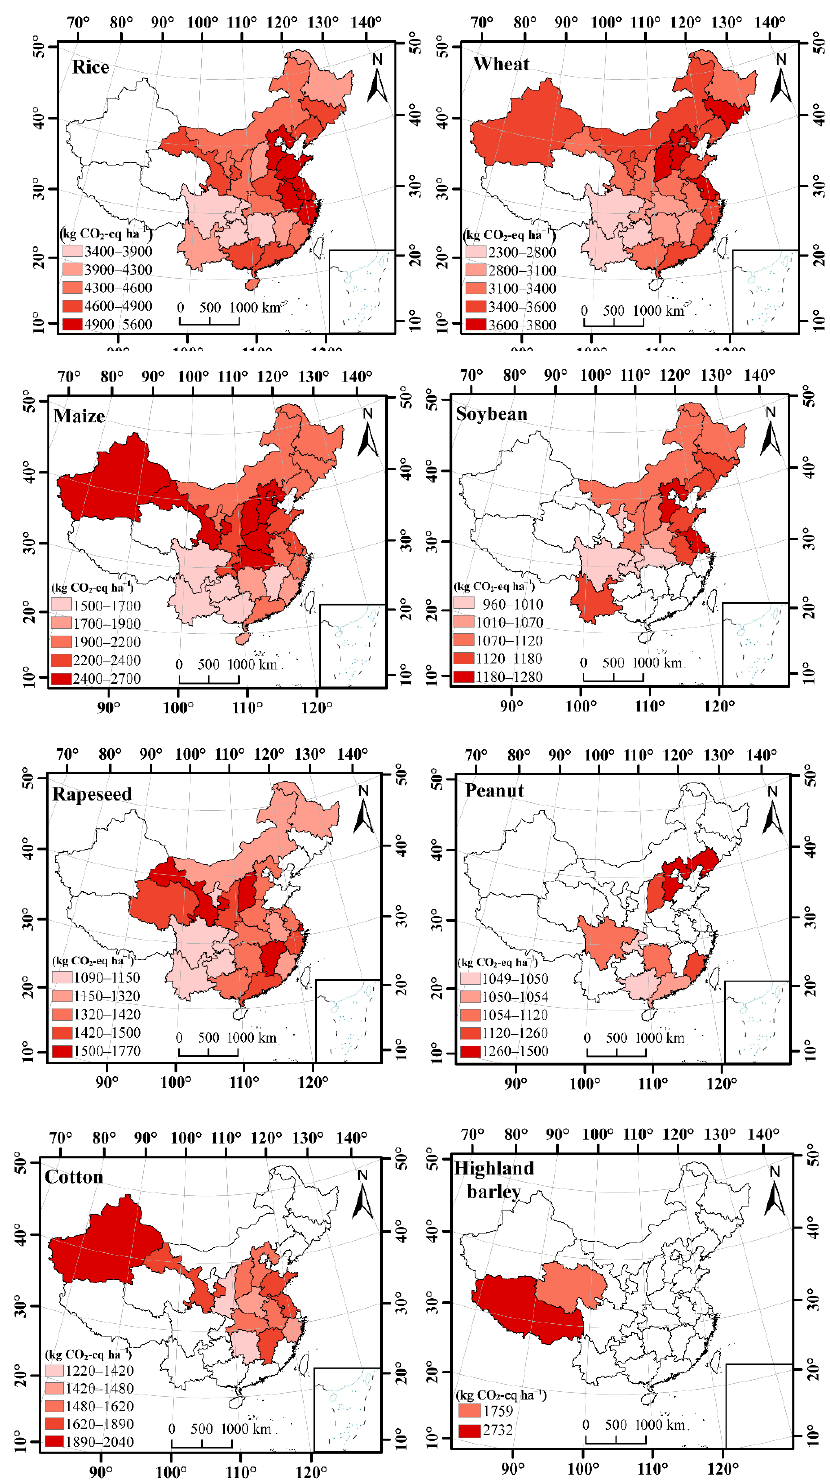
Figure 3. Spatial distributions of the annual mean carbon footprint per unit area ( CF A ) for different crops in China from 1990 to 2019.